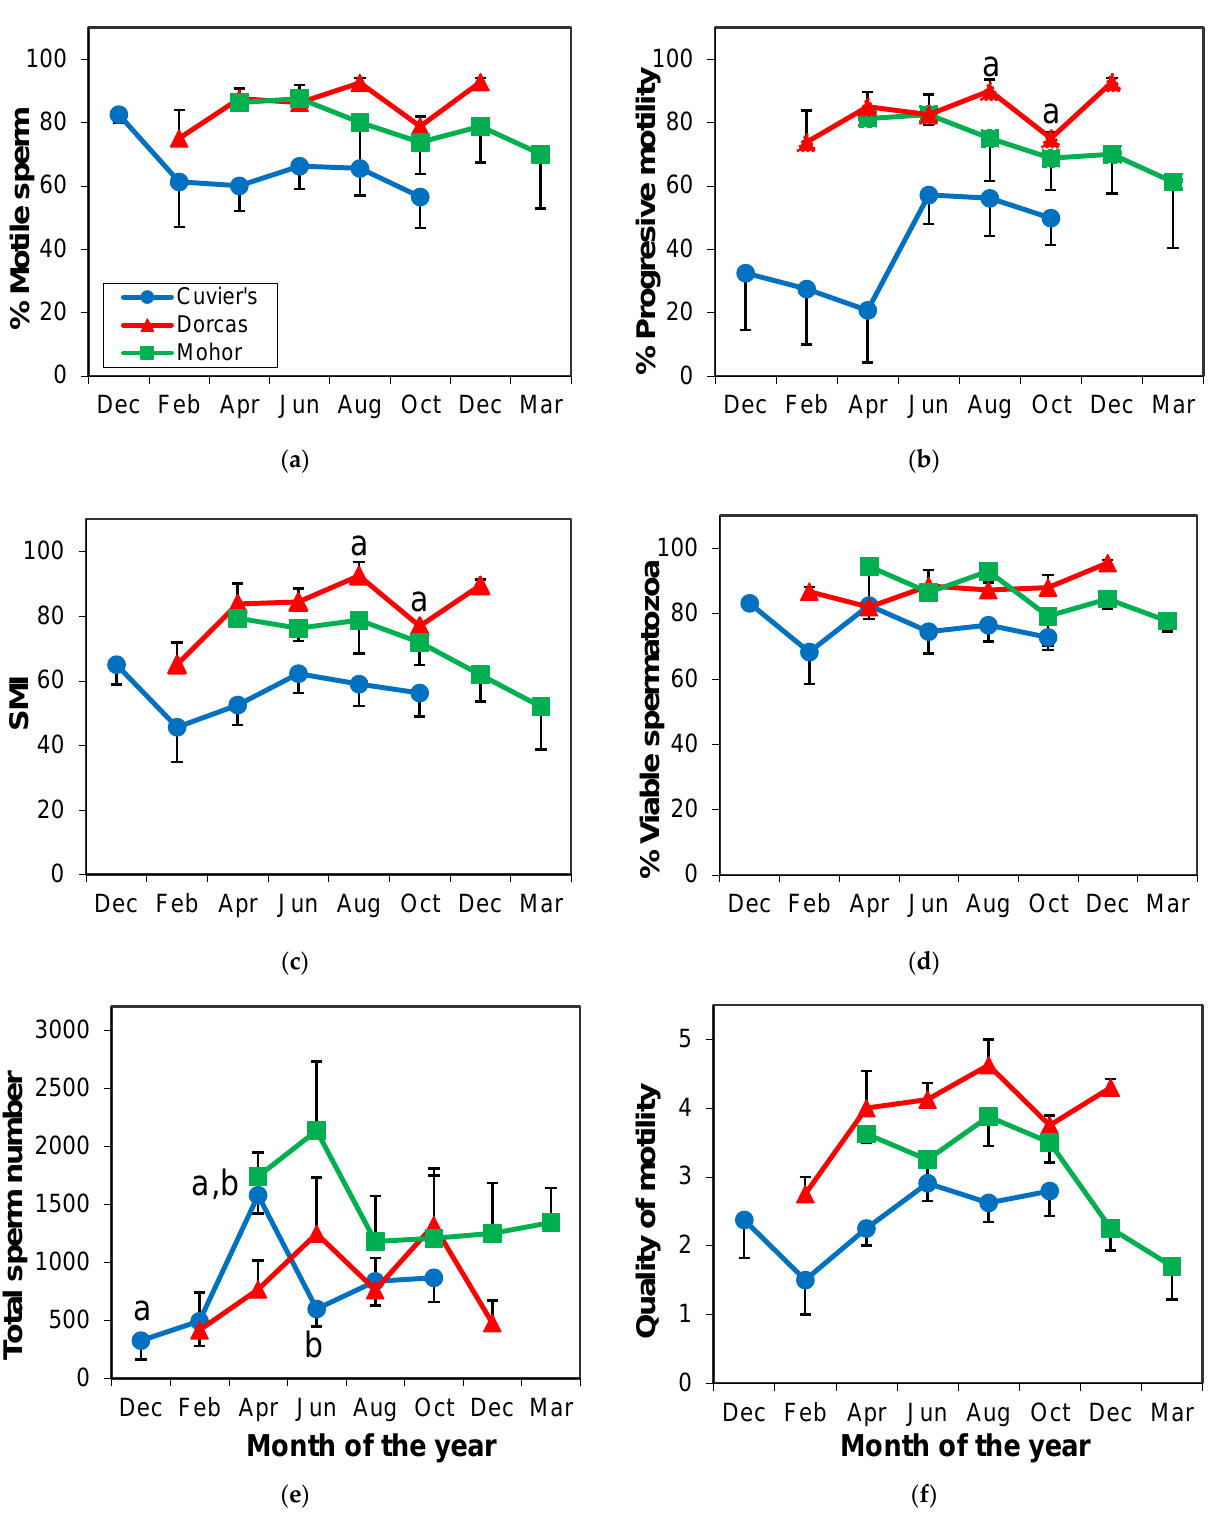
Figure 4. Variation in sperm parameters throughout the year in Cuvier’s, dorcas and Mohor gazelles in Almeria. ( a ) Per- centage of individual motility, ( b ) percentage of progressive sperm, ( c ) sperm motility index (SMI), ( d ) percentage of viable spermatozoa, ( e ) total number of spermatozoa and ( f ) quality of motility. Similar letters indicate differences between months. n = 4 males/species.